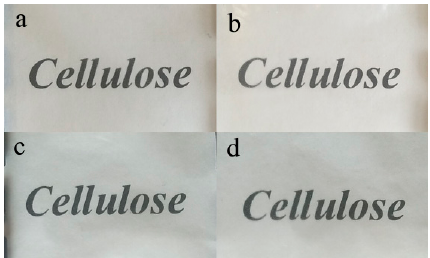
Figure 3. Photograph of specimens prepared by AM: ( a ) RWSC; ( b ) 0.1% CNFs; ( c ) 1.5% CNFs; ( d ) 3.0% CNFs.